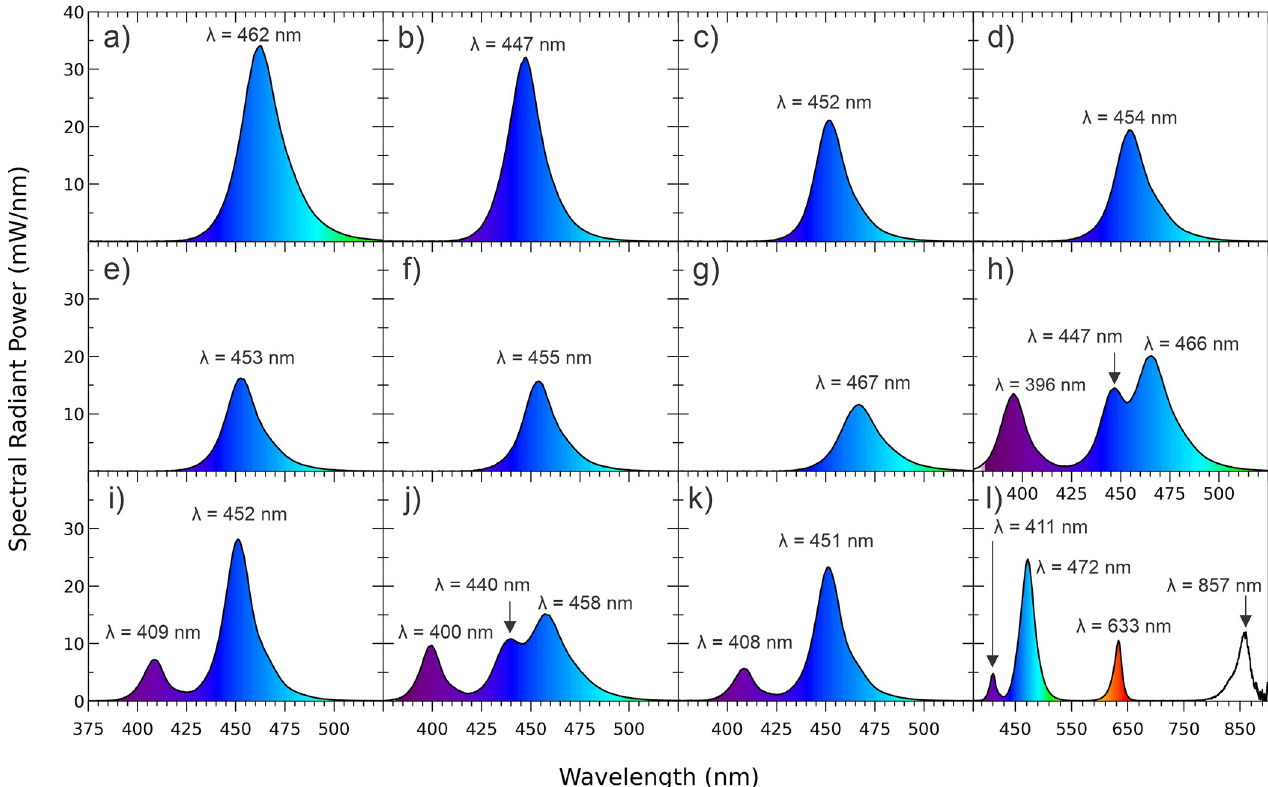
Fig 4. Spectral Radiant Powers (mW/nm) emitted by the 12 LCUs with the emission peaks identified: Single Peak LCUs a) SmartLite Pro; b) DeepCure; c) Dental Spark; d) Denjoy; e) Woodpecker LED D; f) Woodpecker LED B; g) SDI Radii Plus; and Multi-peak LCUs h) Valo Grand; I) Bluephase G4; j) Valo; k) Bluephase Powercure; and l)